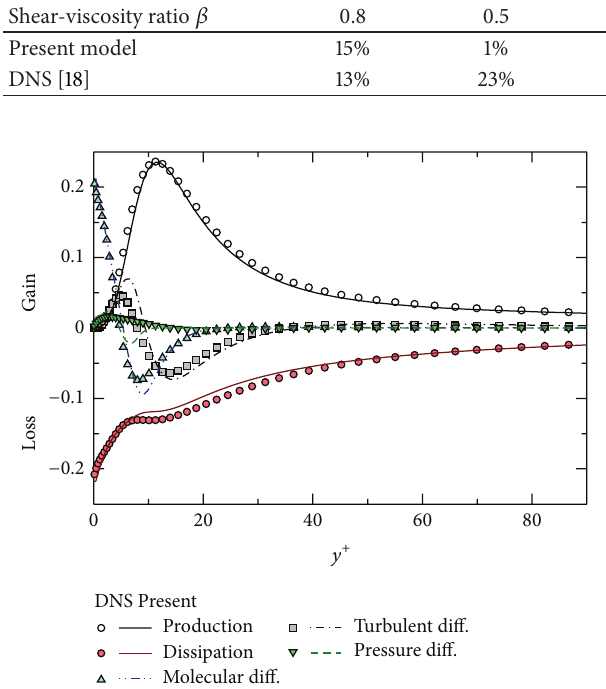
Figure 5: Budget of turbulent kinetic energy for Newtonian fluid in turbulent channel flow at Re 𝜏 = 395 with emphasis on the near-wall